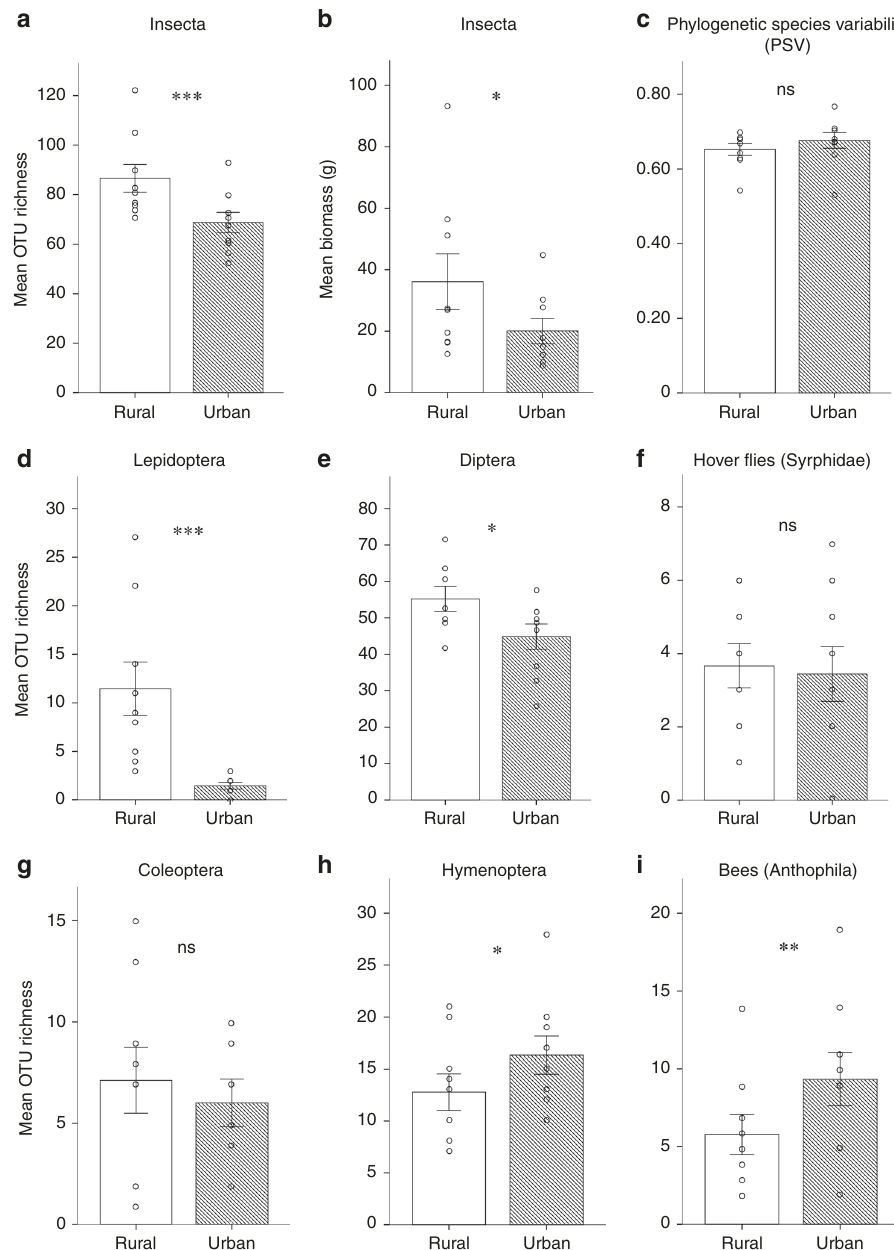
Fig. 2 Insect biodiversity at fl ower-rich rural versus paired fl ower-rich urban sites. Insect biodiversity at N = 9 fl ower-rich rural versus N = 9 paired fl ower-rich urban sites as a mean species richness (number of OTUs) of Insecta, b insect biomass, c insect phylogenetic species variability (PSV), as well as species richness of d Lepidoptera, e Diptera, f hover fl ies (Syrphidae) (a subset of ( e )), g Coleoptera, h Hymenoptera, and i bees (Anthophila) (a subset of ( h )); means ± SE are shown; GLMM and LMM: ns, not signi fi cant, one star, P < 0.05, two stars, P < 0.01; three stars, P <